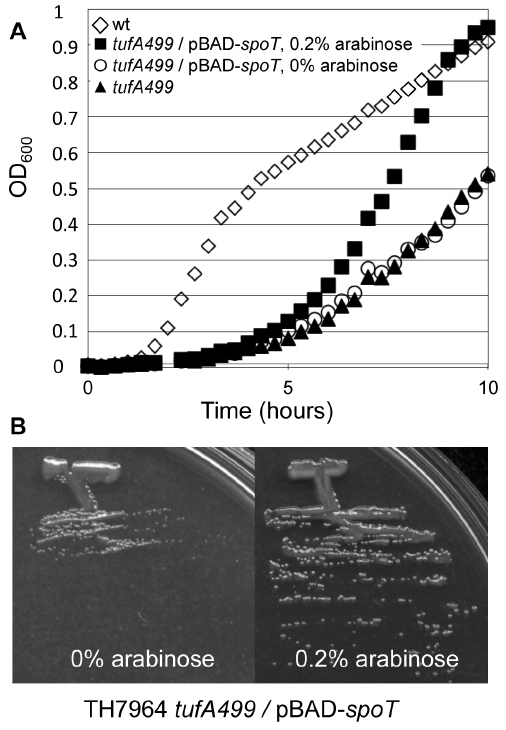
Figure 1. Overexpression of spoT increases mutant growth rate and growth yield. (A) Growth as a function of overexpression of spoT . TH7507 ( tufA + ), TH7509 ( tufA499 ), and TH7964 ( tufA499 /pBAD- spoT ) grown with or without added arabinose (0.2%) in LB. Growth curves are from a single, representative experiment. (B) TH7964 ( tufA499 /pBAD- spoT ) grown on LA plates for 16 h at 37 u C. Left panel: no arabinose added; Right panel: 0.2% arabinose added to induce expression.